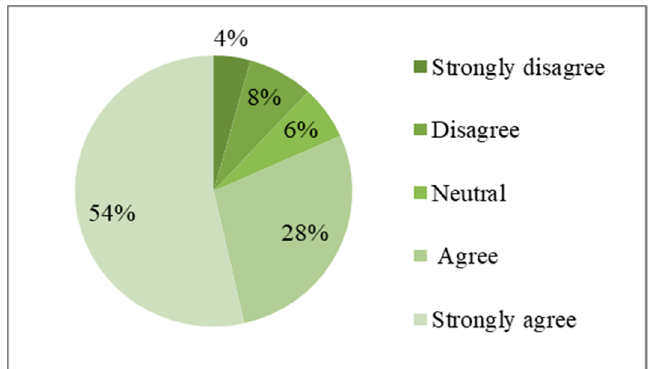
Figure 6. Another major earthquake will seriously affect residents’ lives and safety of property.